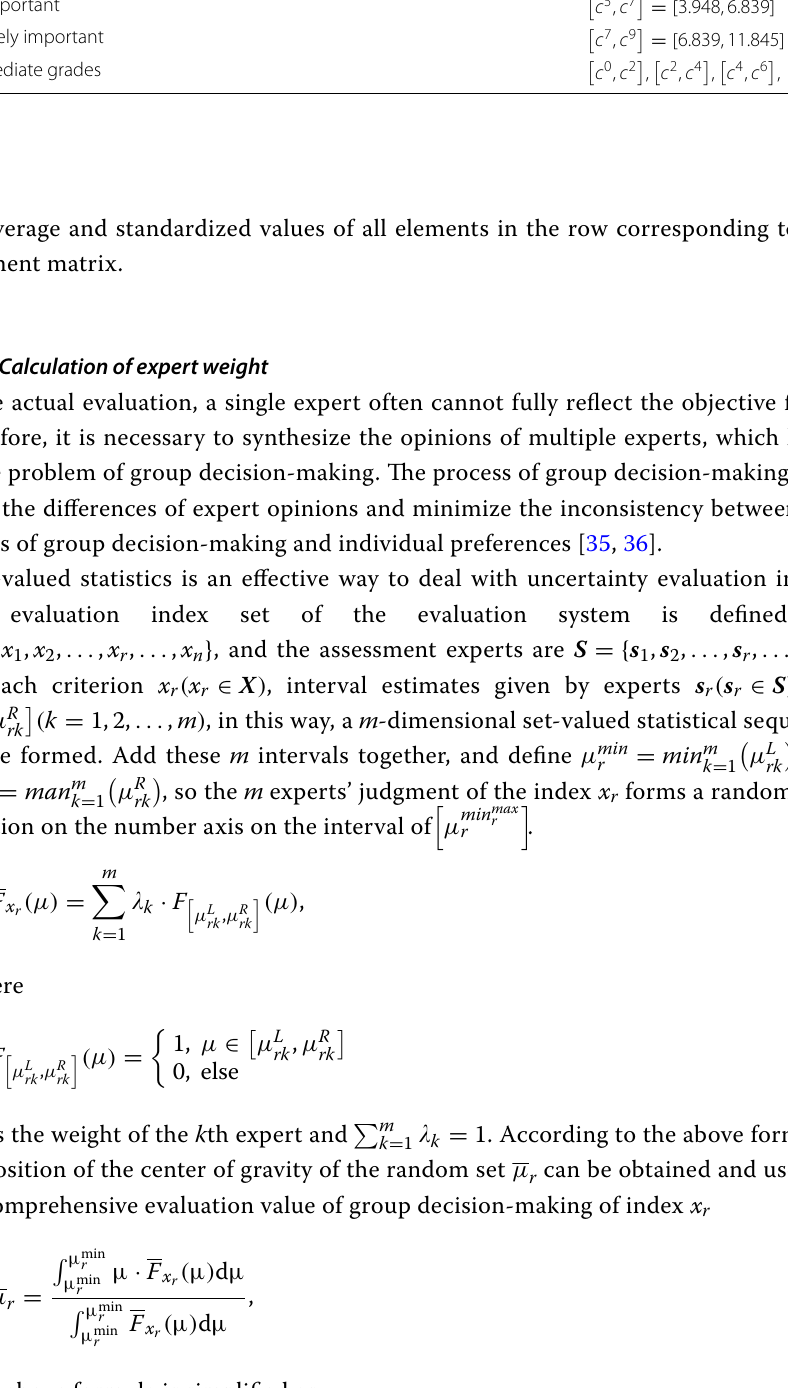
Table 1 Index interval number scale Natural language description Scale interval Equal important